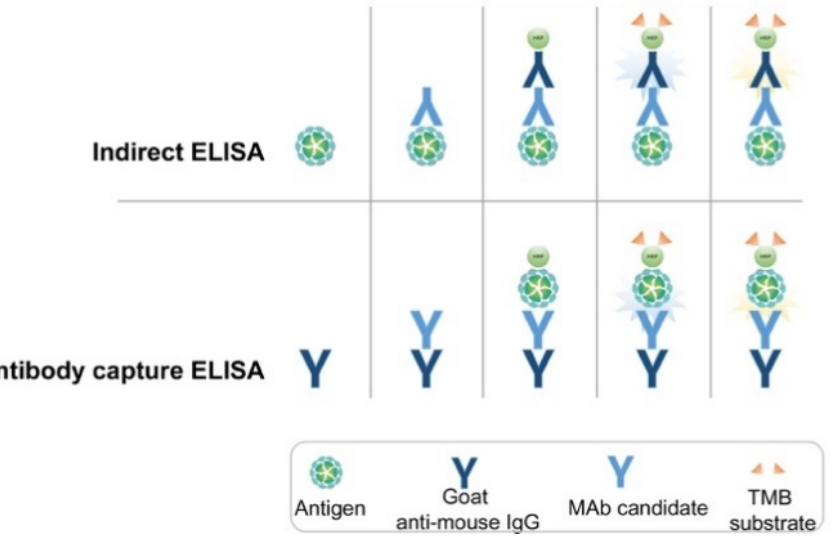
Figure 1. Schematic representation of indirect and antibody-capture ELISA assays used for screening and selection of MAb pairs.